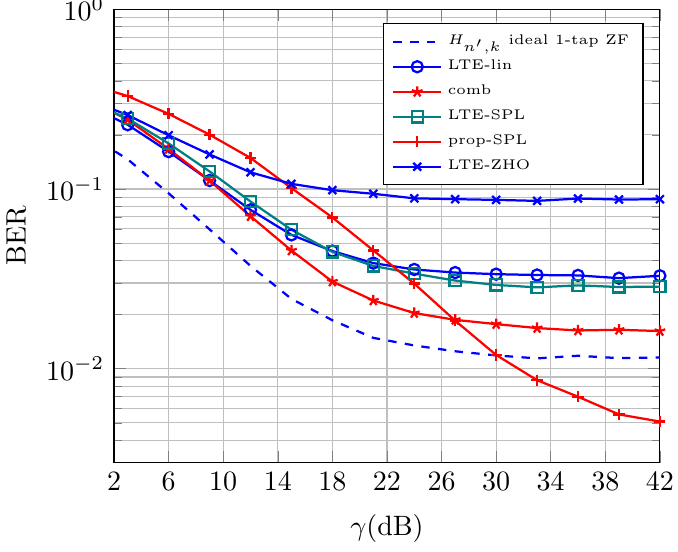
Figure 7. BER versus Signal-to-Noise Ratio (SNR) under ITU-Vehicular A channel model for different channel estimation and equalization